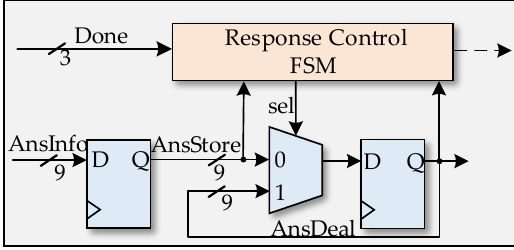
Figure 3. Description of the response control level.